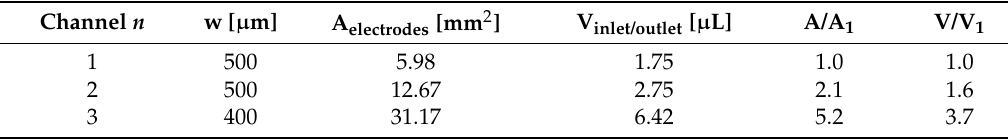
Table 2. Ionization chamber